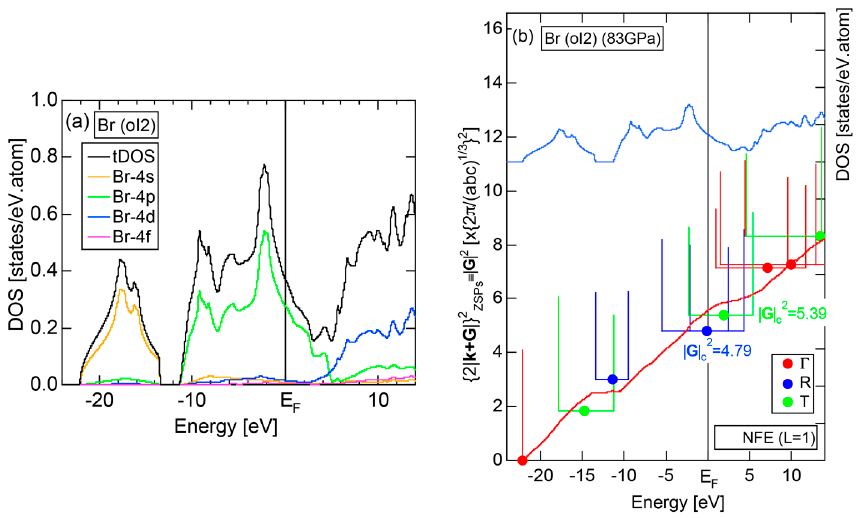
Figure 15. ( a ) Partial DOSs; ( b ) FLAPW-Fourier spectra at symmetry points Γ , R and T of the Brillouin zone for the body-centered orthorhombic lattice for metallic Br (oI2) [11]. The total-DOS is incorporated in (a).